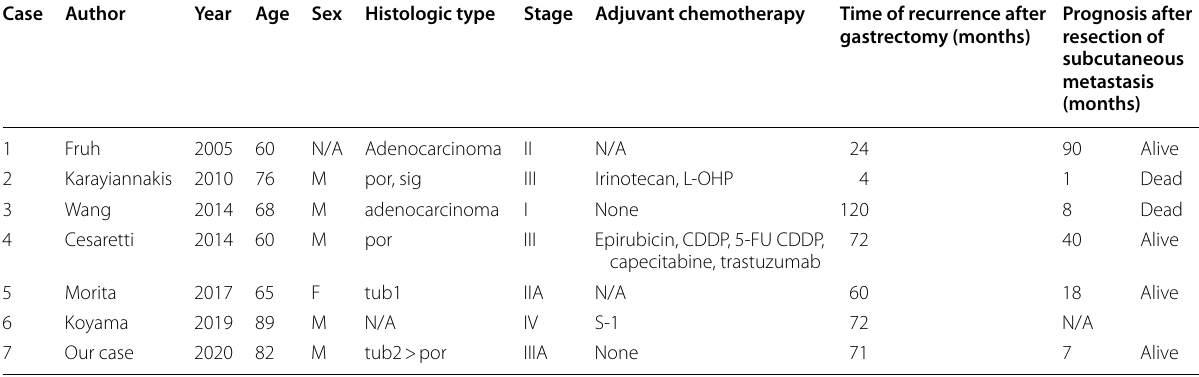
M male, F female, N/A not available, por poorly differentiated adenocarcinoma, sig signet ring cell carcinoma, tub2 moderately differentiated adenocarcinoma, tub1 well-differentiated adenocarcinoma, L-OHP oxaliplatin, 5-FU 5-fluorouracil, CDDP